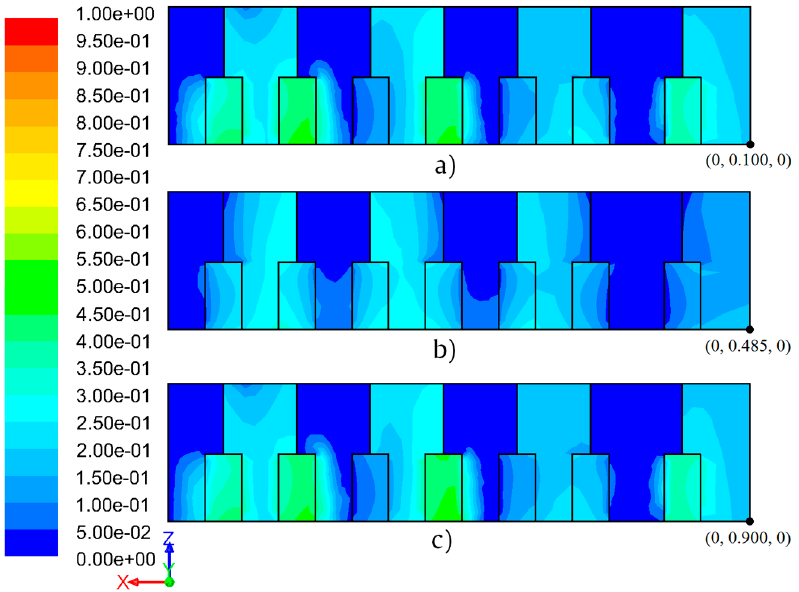
Figure 9. The results of the field of temperature in the x–z plane through the planes: ( a ) y adm = 0.100; ( b ) y adm = 0.485; and ( c ) y adm = 0.900.